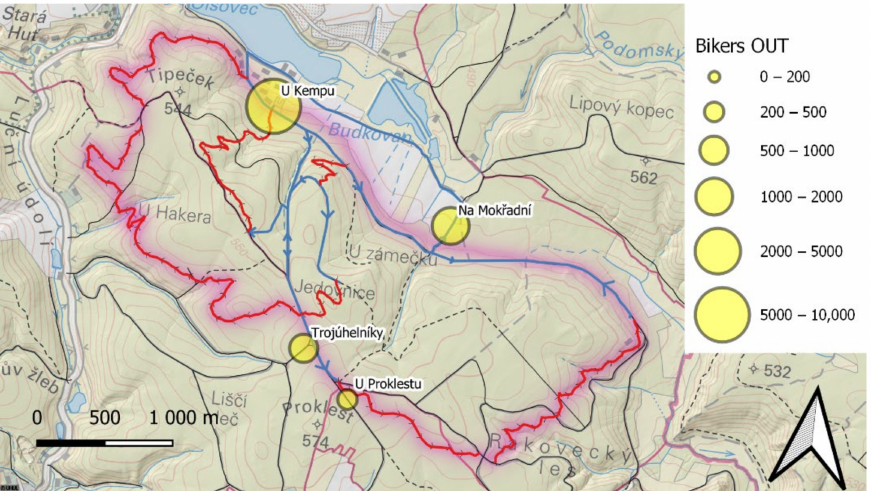
Figure 6. Number of cyclists in the direction out of the area.